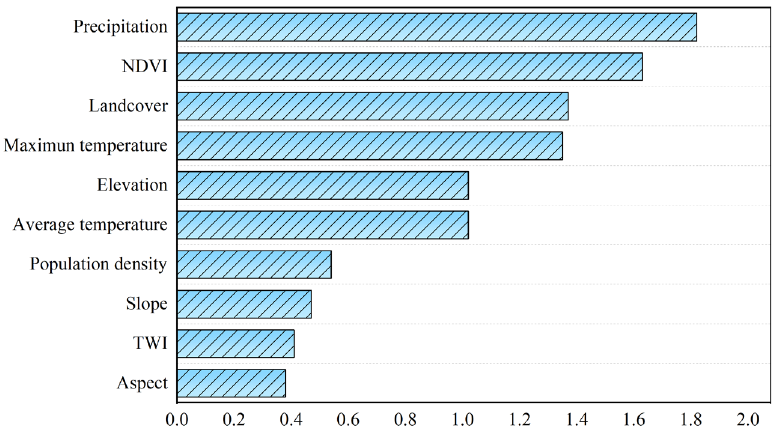
Figure 6. Ranking the importance of triggering factor features.